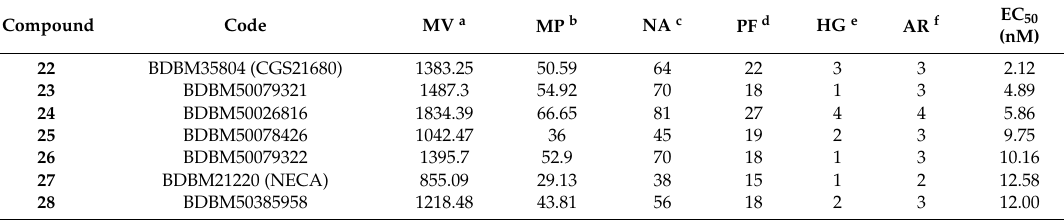
Table 4. Molecular descriptors selected for QSAR modeling. Compound